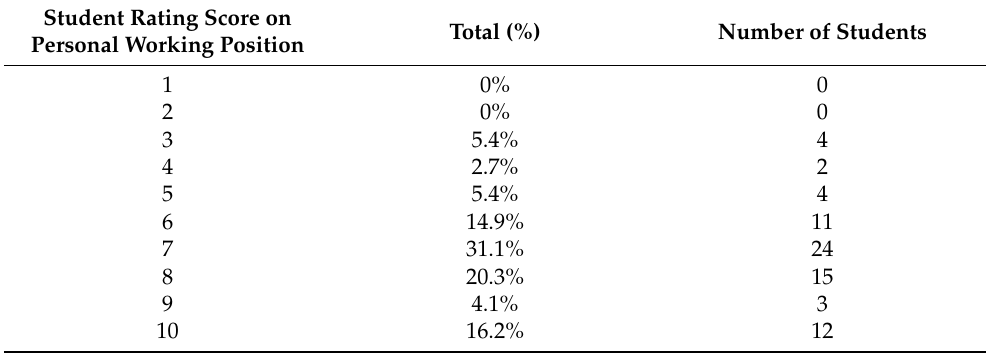
Table 3. Student self-assessment of their current working posture during clinical dental procedures.